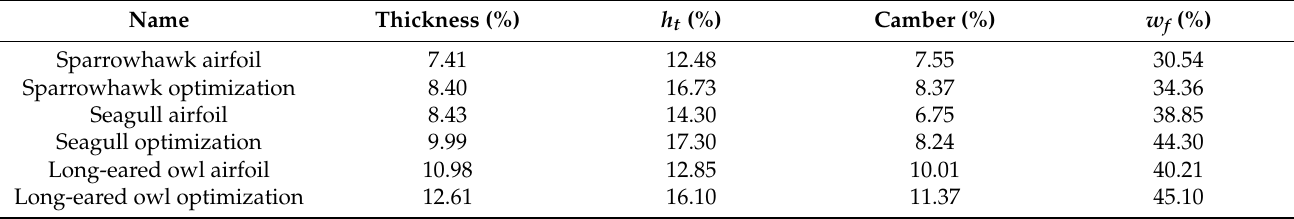
Table 3. Comparison of airfoil structures before and after